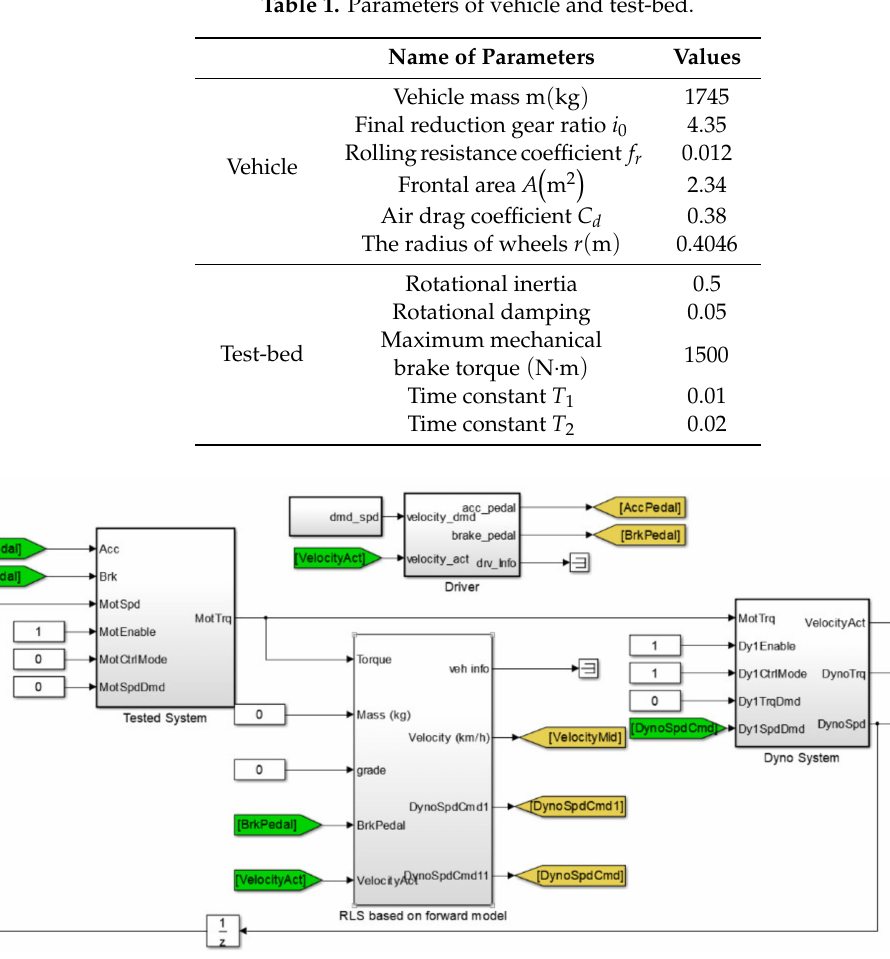
Figure 8. The simulation platform developed based on MATLAB /